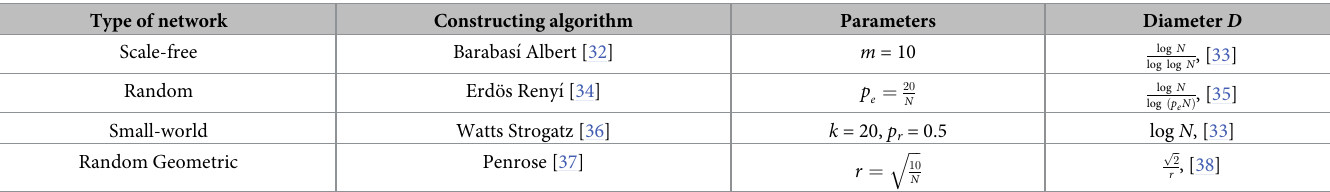
Table 3. The analyzed